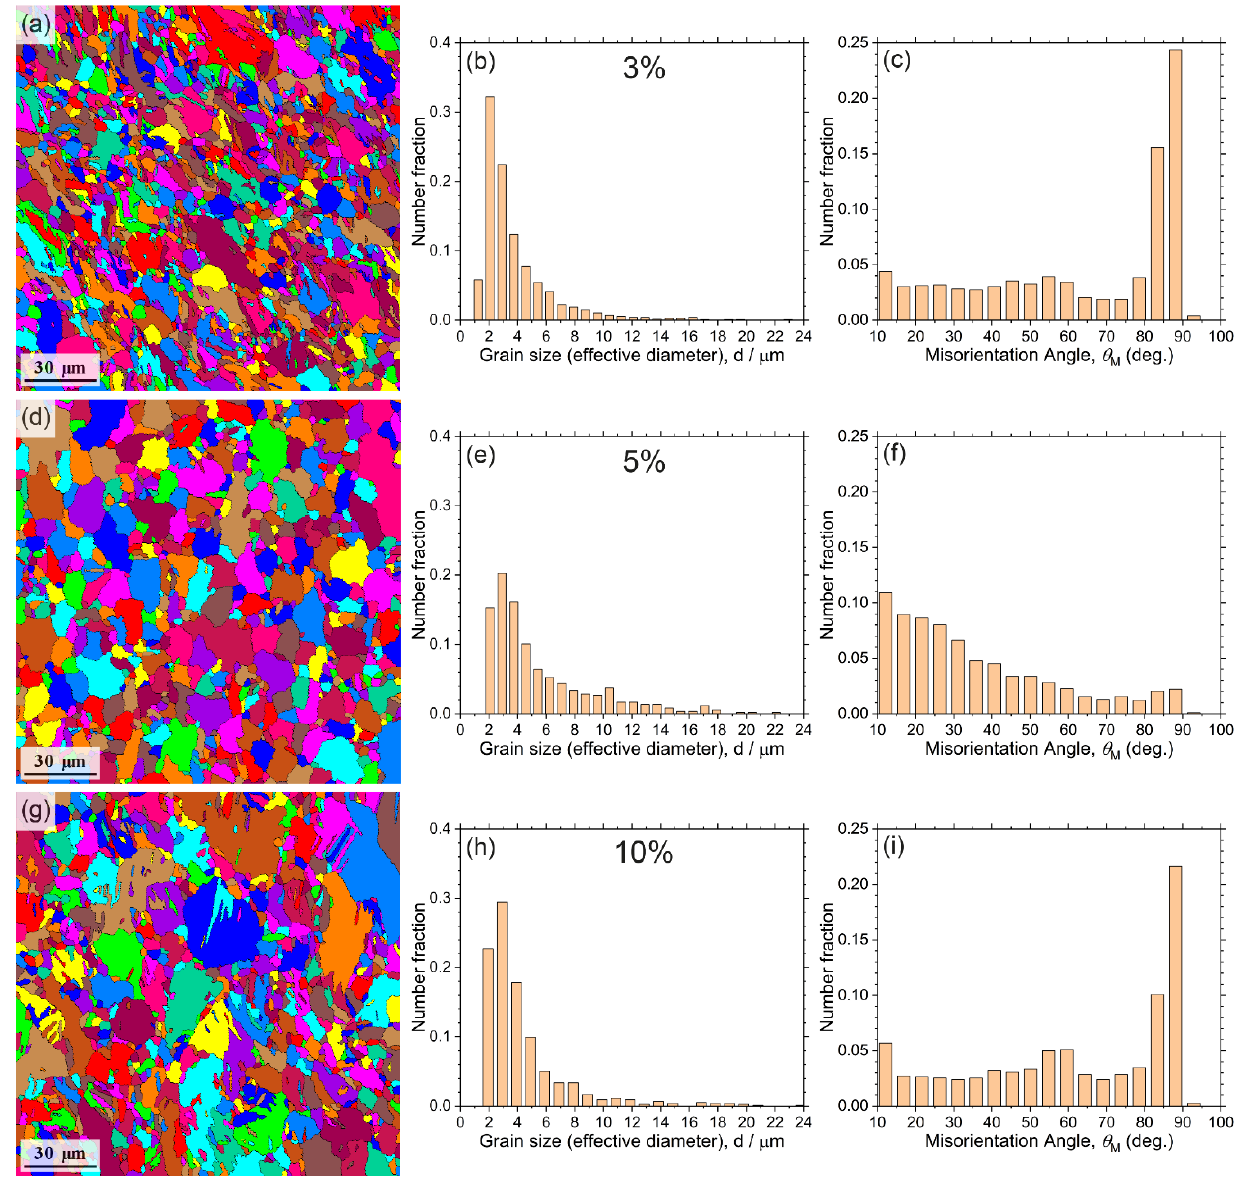
Figure 10. The grain structure of the alloy Mg-1Zn-0.2Ca alloy ( a , d , g ) and corresponding distributions of the effective grain size ( b , e , h ) and angles of misorientation between grains ( c , f , i ) after testing at . ε = 5 × 10 − 3 s − 1 to 3% ( a – c ), 5% ( d – f ), and 10% ( g – i ) 200 ◦ C and